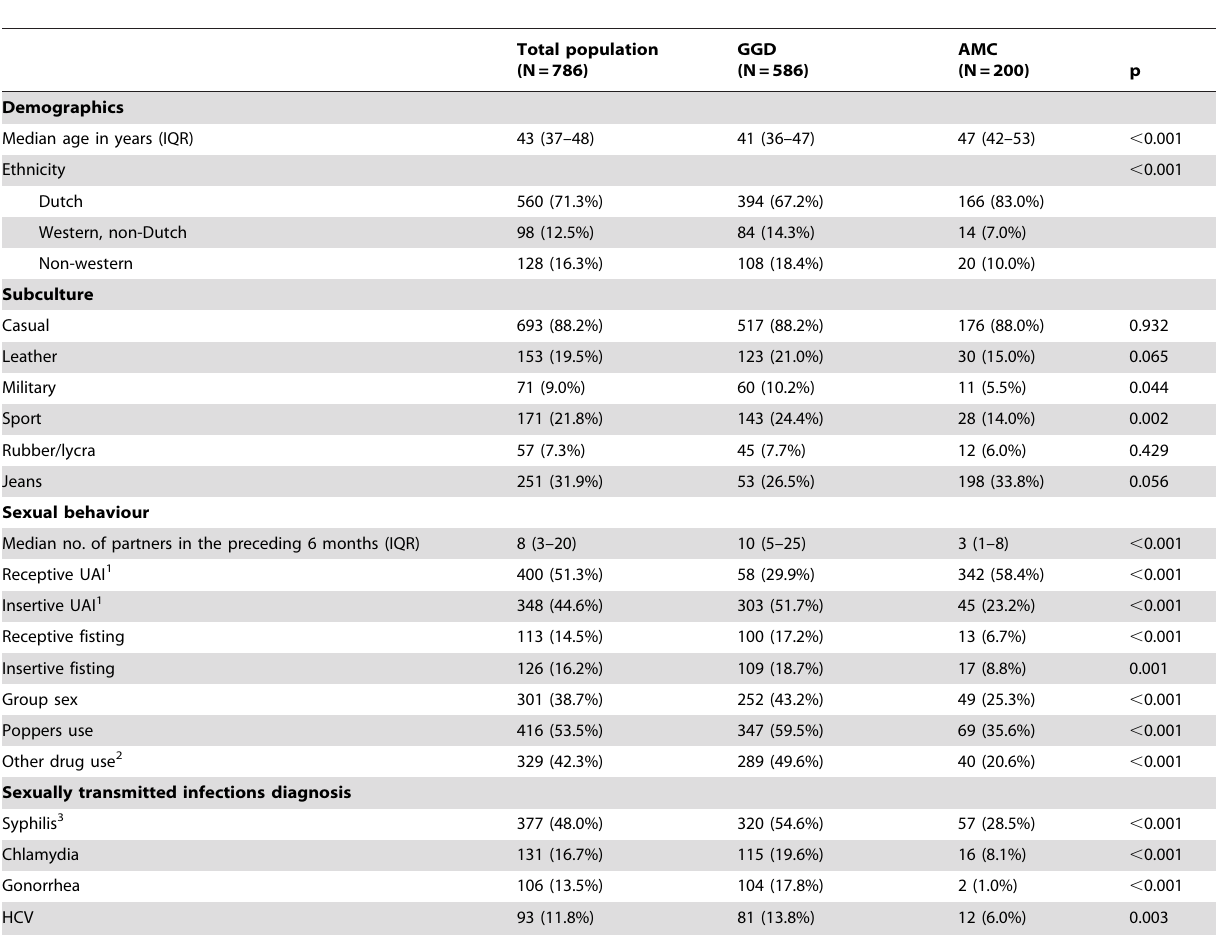
Table 1. Characteristics of 786 HIV-infected MSM, by recruitment location, who visited the STI outpatient clinic of the Public Health Service or the HIV outpatient clinic of the Academic Medical Center in Amsterdam, the Netherlands,